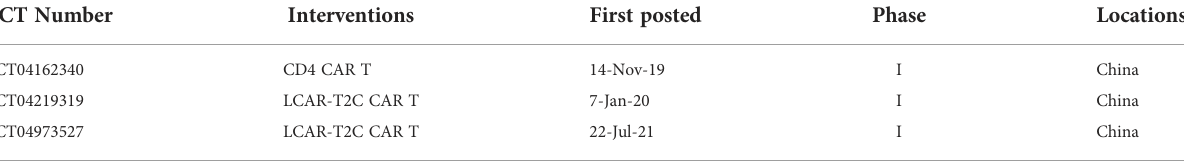
TABLE 3 Recruiting CD4 CAR clinical trials.